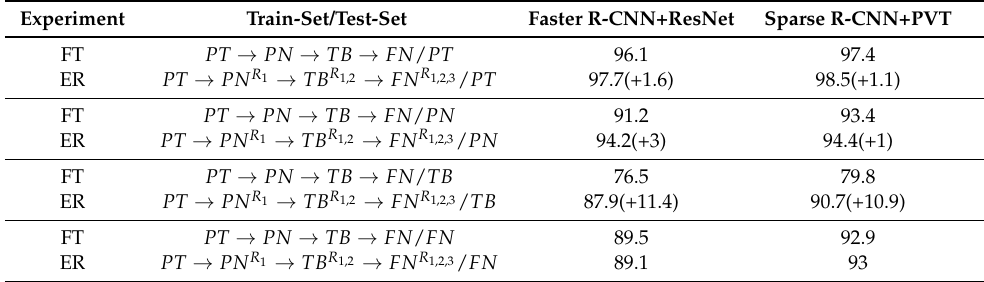
Table 3. The mAP results of different experiments on multiple test-sets. FT is the Fine-tuning, and ER is the Experience replay. Acronyms TB, PN, PT, and FN denote TableBank, PubLayNet, PubTables- 1M, and FinTabNet, respectively. The R superscripts for ER, demonstrate the index of the previous datasets contributing to the replay memory.